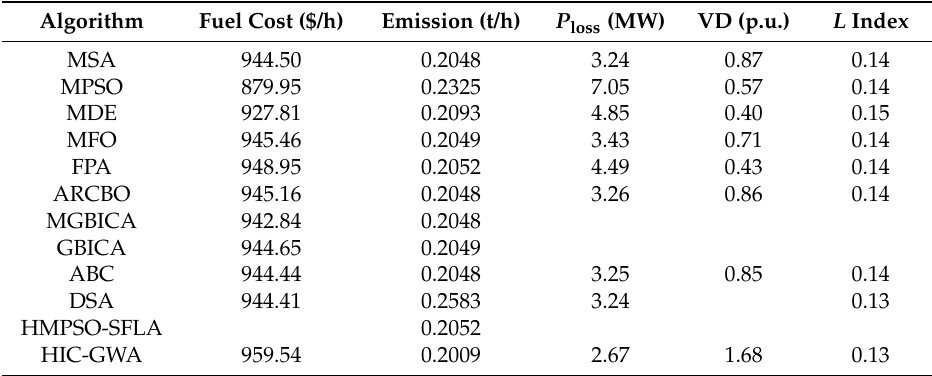
Table 8. Comparison of HIC-GWA with the literature for case study